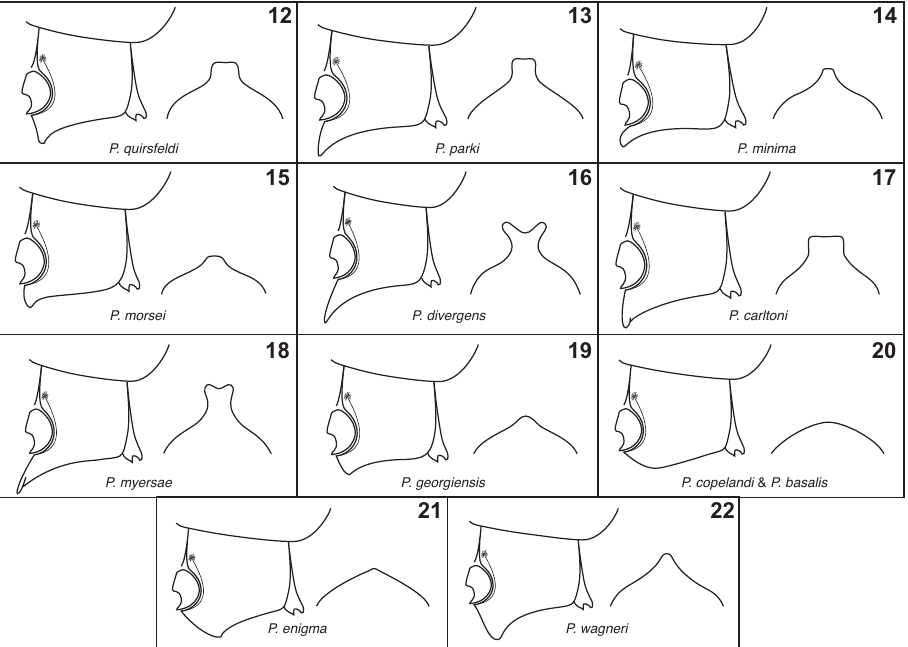
Figures 12–22. Metaventrites, lateral (left) and posterior (right) views. 12 P. quirsfeldi 13 P.